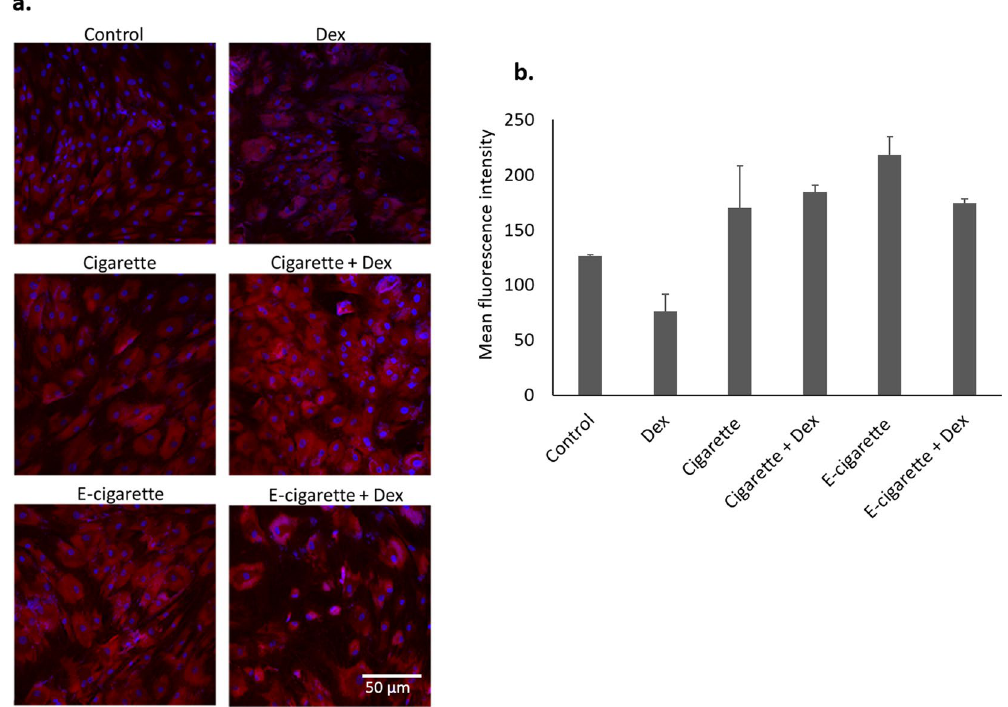
Figure 4. Cigarette and e-cigarette smoke extracts enhance ROS production. ( a ) MSCs were treated with cigarette and e-cigarette smoke extracts for 14 days. ROS generation was evaluated using the DHE assay, counterstained with DAPI and observed by fluorescence microscopy. Red indicates presence of ROS. ( b ) Quantification of ROS generation. DHE mean fluorescence intensities of 5 fields from 2 images per condition were measured using the Zen 2011 software. Histograms display averages ± SD of mean fluorescence